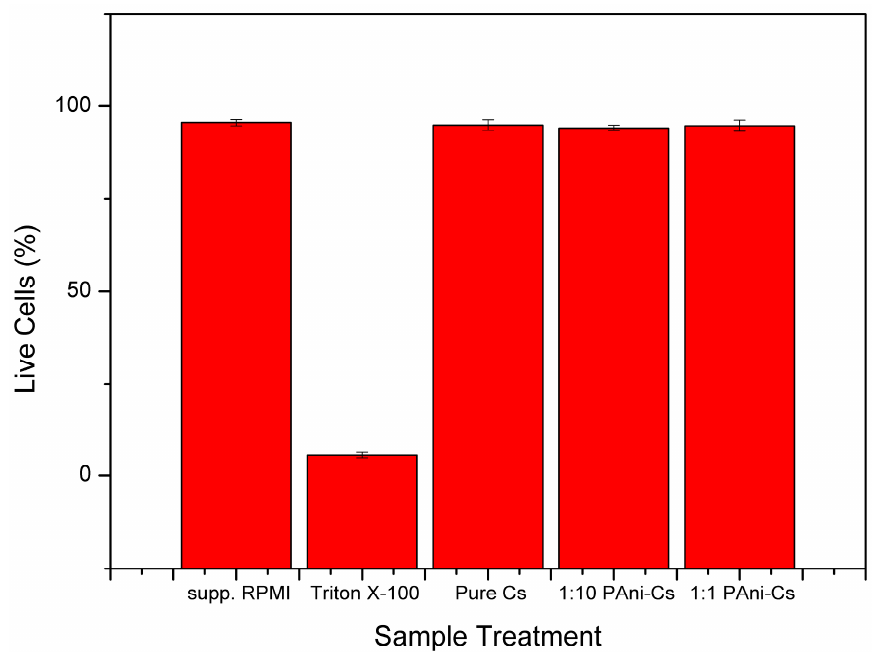
Figure 8. Cytocompatibility assay of ( a ) pure chitosan (Cs), ( b ) 1:10 polyaniline–chitosan (PAni–Cs), and ( c ) 1:1 PAni–Cs.